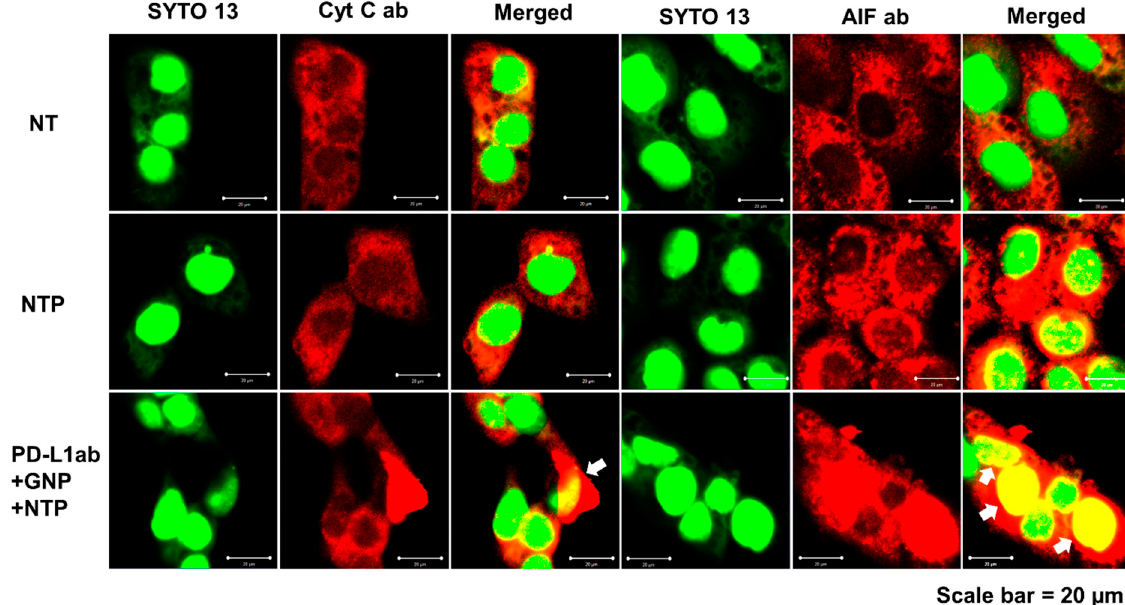
Figure 7. Induction of apoptosis in SCC-25 cells. Upon treatment with PD-L1 ab + GNP + NTP, after 4 h of incubation, immunocytochemistry visualized the redistribution of cyt C and AIF using an anti-cyt C antibody and an anti-AIF antibody, respectively. Translocation of cyt C and AIF are indicated with arrows. Abbreviations: NT, nontreatment; ab, antibody; GNP, gold nanoparticle; NTP, nonthermal plasma; cyt C, cytochrome C; AIF, apoptosis-inducing factor. This section may be divided by subheadings. It should provide a concise and precise description of the experimental results and their interpretation, as well as the experimental conclusions that can be drawn.